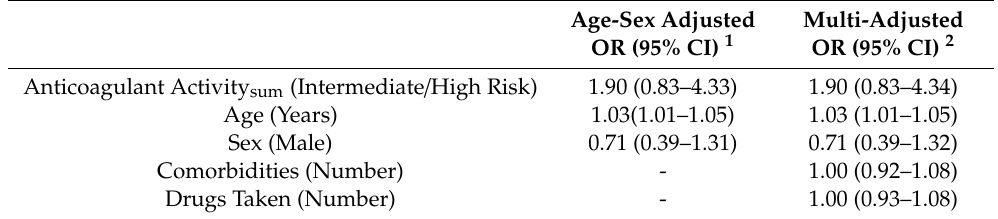
Table 4. Results of the regression analyses for suspected phenprocoumon based on the pharmacogenomic anticoagulant